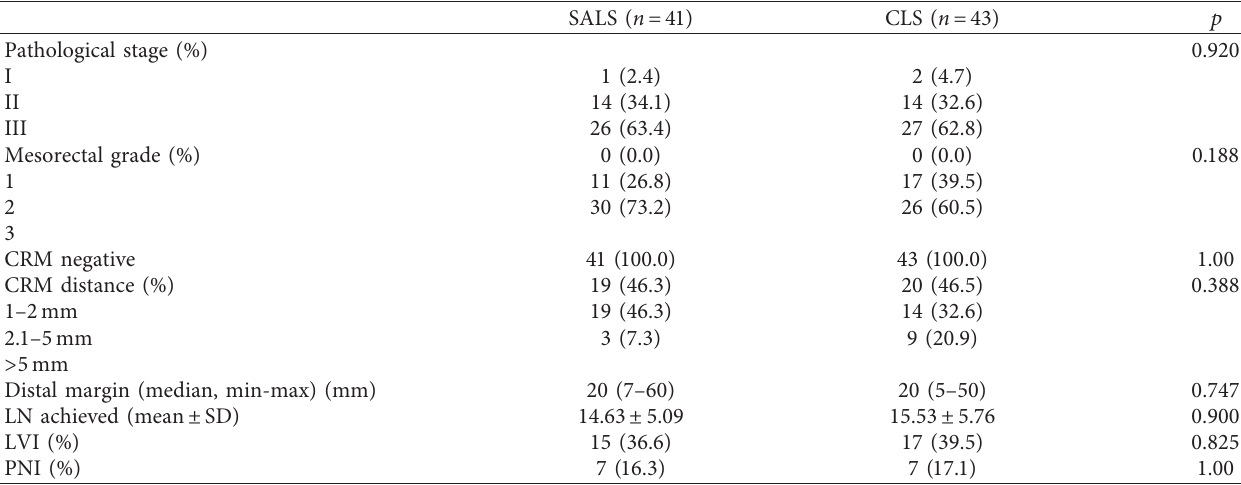
Table 3: Pathologic data.